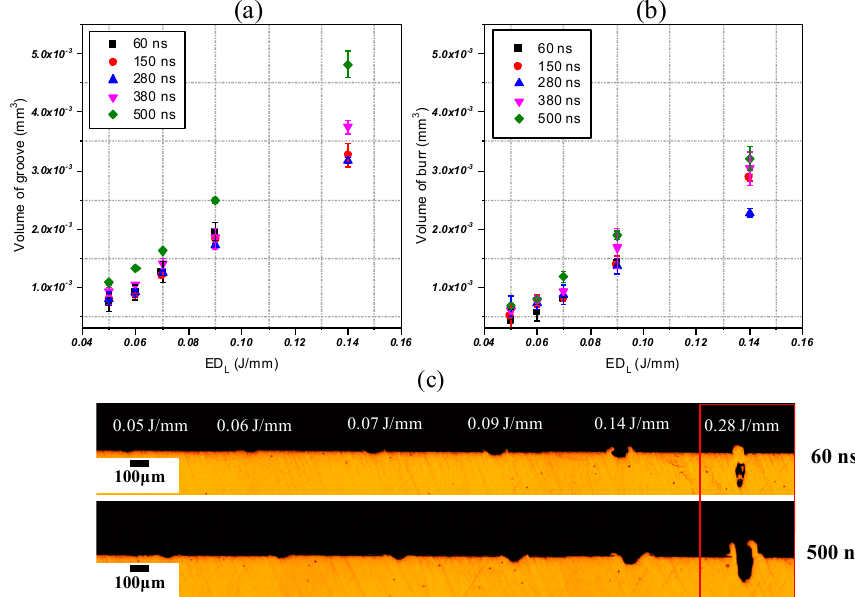
Figure 6. ( a ) Extracted volume of groove and ( b ) extracted volume of burr produced as a function of line energy dose ( ED L ) for di ff erent pulse durations at PRF 0 . ( c ) Cross section of grooves produced at 60 ns and 500 ns pulse durations for different energy doses. The parameter combinations highlighted in red have been excluded from further experiments as the quality of machining is poor.